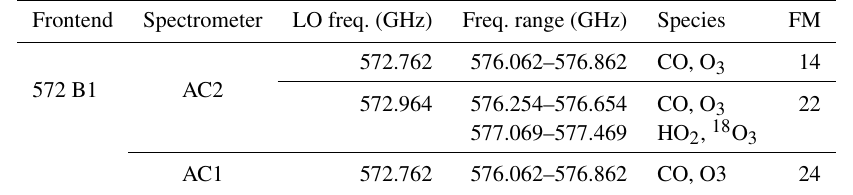
Table 1. FMs for observing CO. From Rydberg et al. (2017).